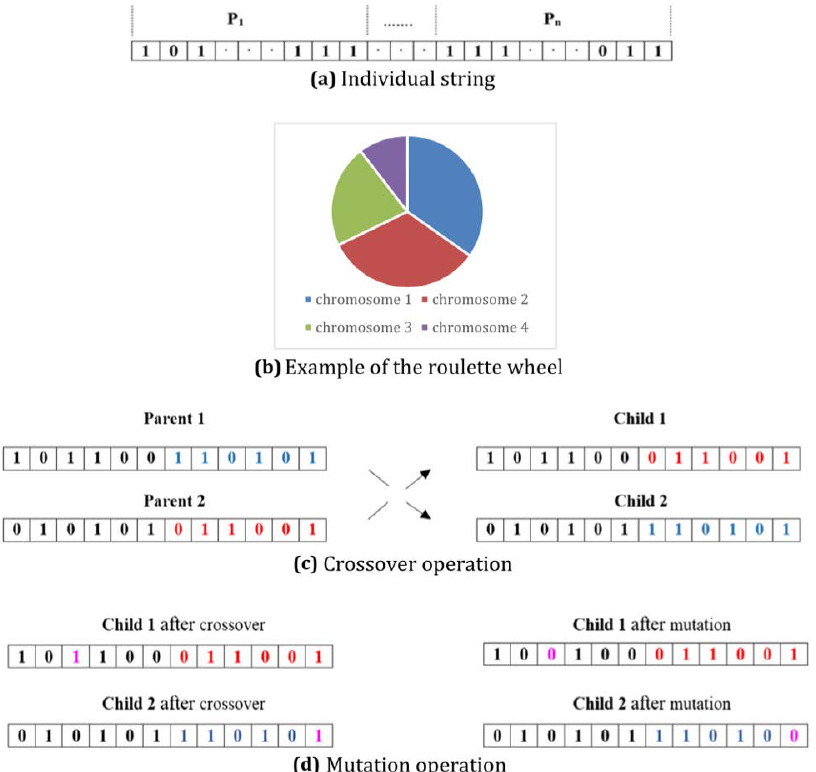
Figure 8. An example of the genetic algorithm steps [115].